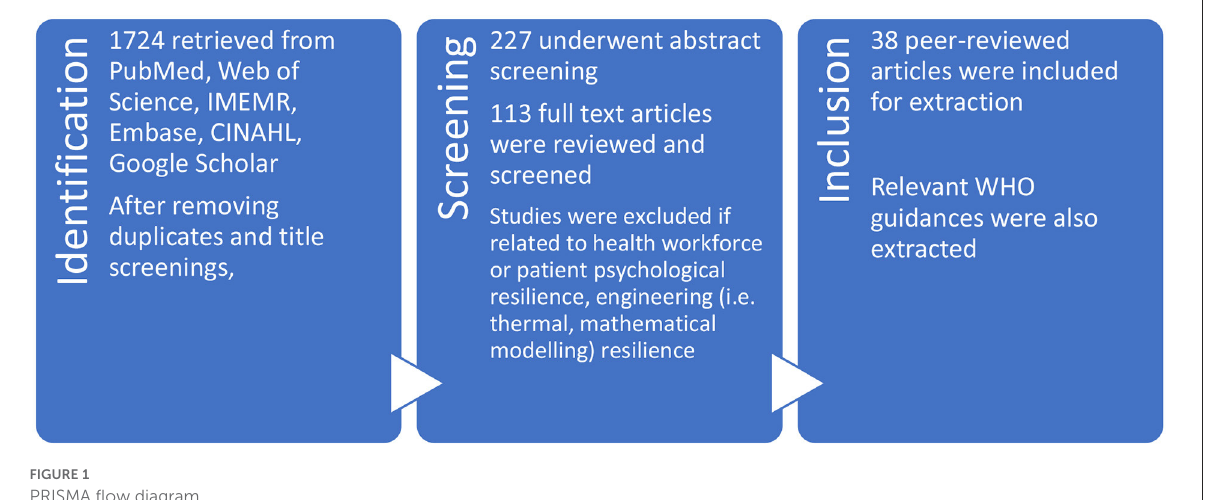
FIGURE1 PRISMA flow